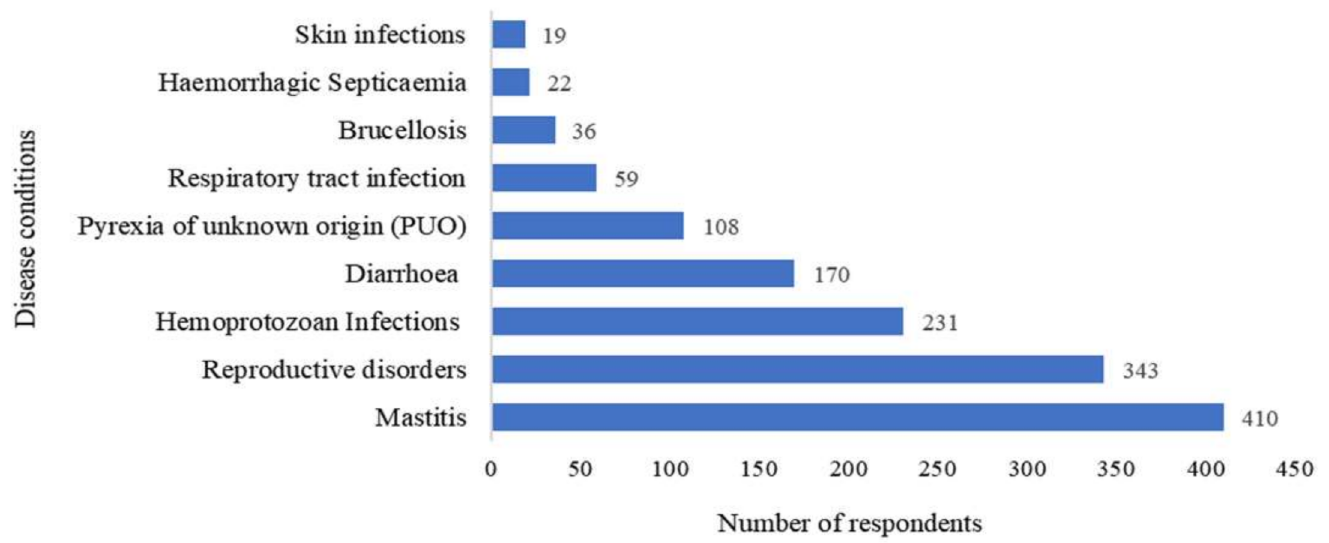
Figure 1. Major disease conditions requiring antibiotic use in bovines in India * (* Question: Top 03 disease conditions that require antibiotic use in bovines. Each veterinarian was asked to choose up to three disease